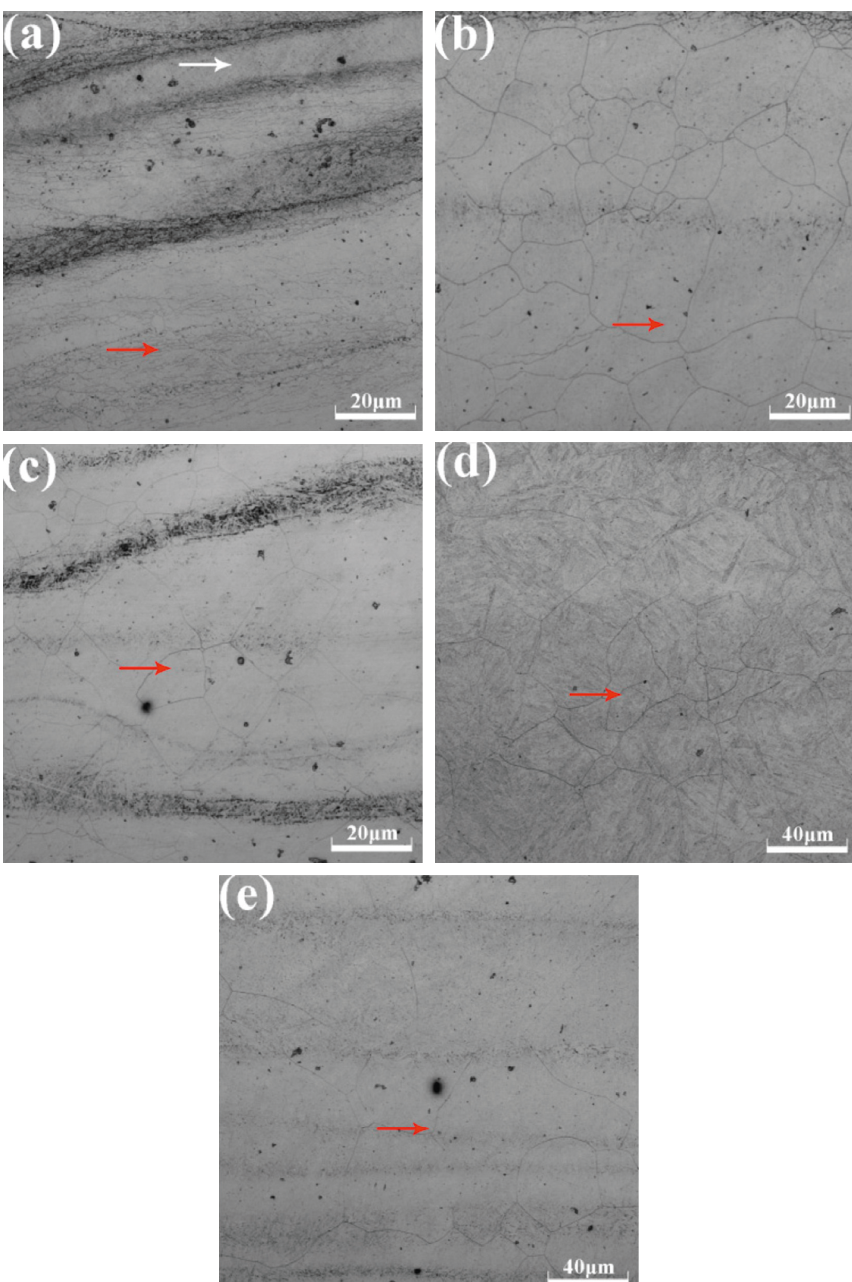
Figure 11: Optical microstructure of 5CrNiMoV steel deformed at the strain rate of 1s − 1 : (a) T � 830 ° C, (b) T � 930 ° C, (c) T � 1030 ° C, (d) T � 1130 ° C, and (e) T � 1230 ° C.